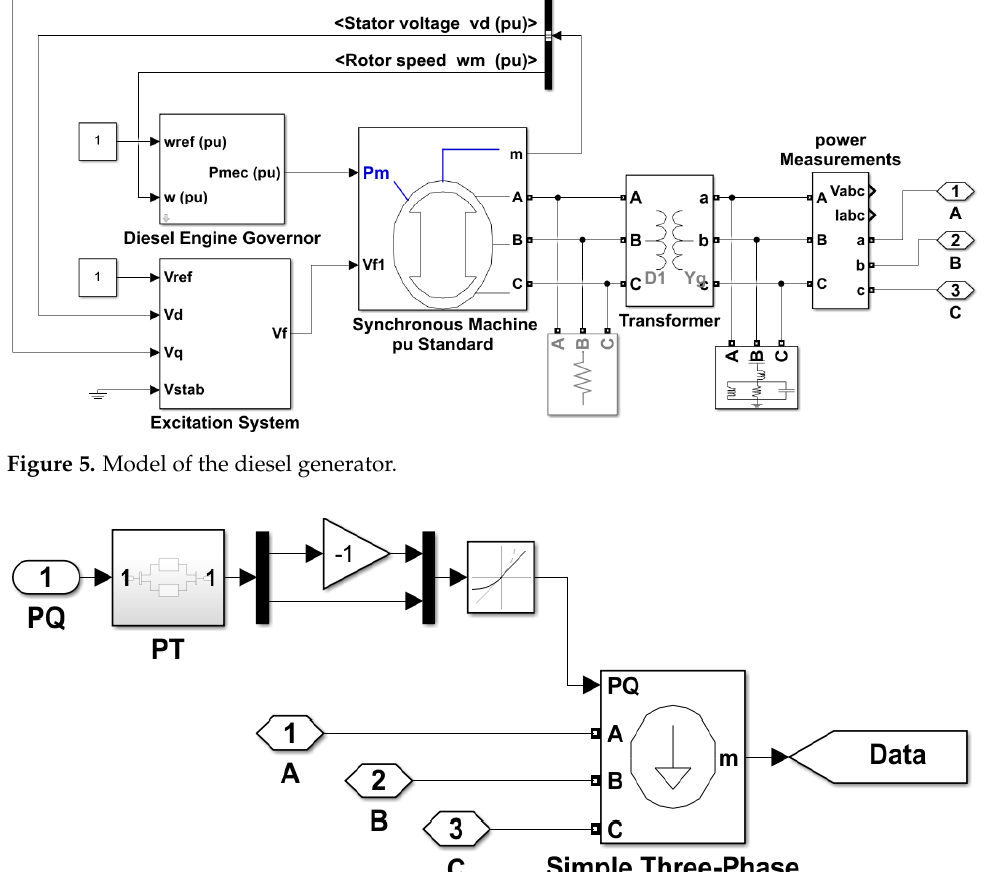
Figure 6. Model of load, EV and PVs.